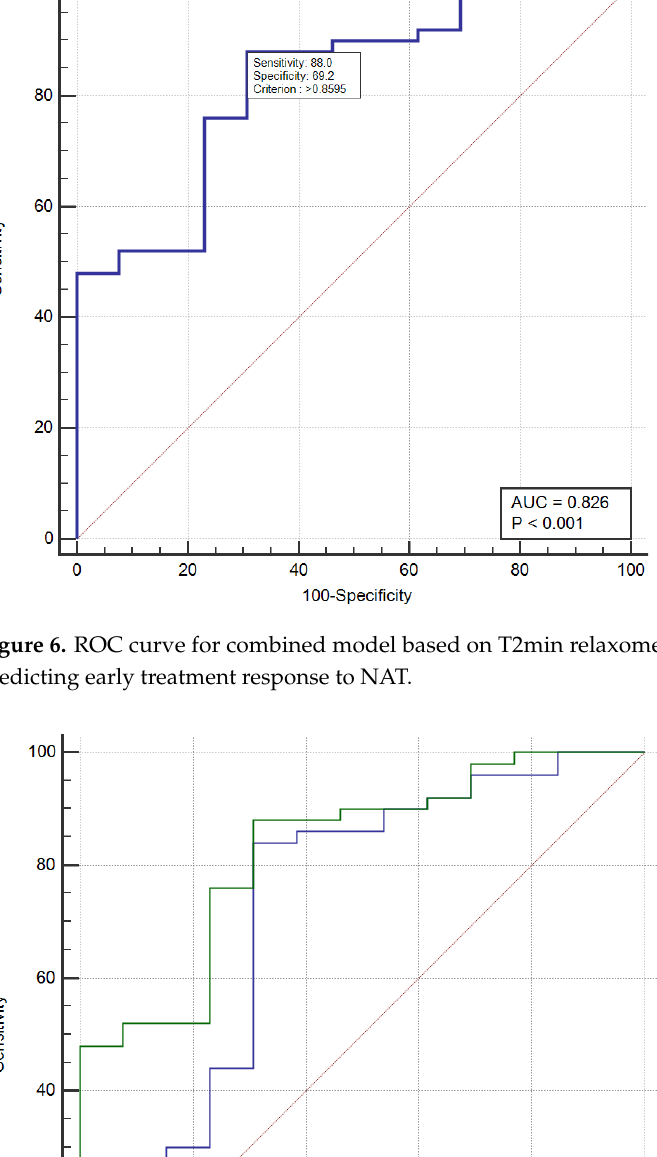
8 of 12 Figure 5. ROC curve for T2min relaxometry parameter in predicting early treatment response to